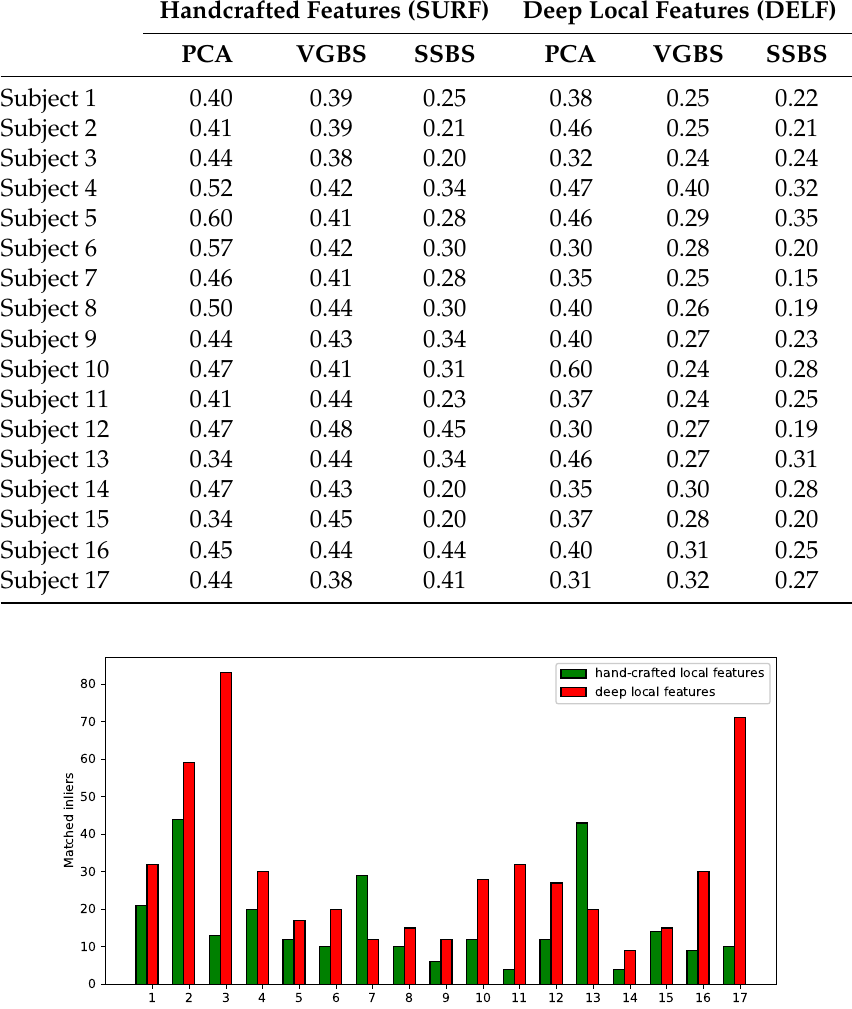
Figure 9. The barplot presents the average number of matched inliers per subject when the band selection algorithms are applied. The number of matched inliers using SURF and DELF are indicated and visualized in the plots